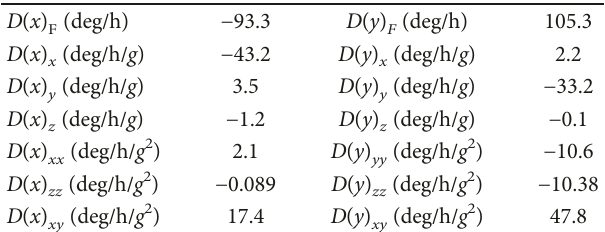
Table 1: Nominal values of calibration coe ffi